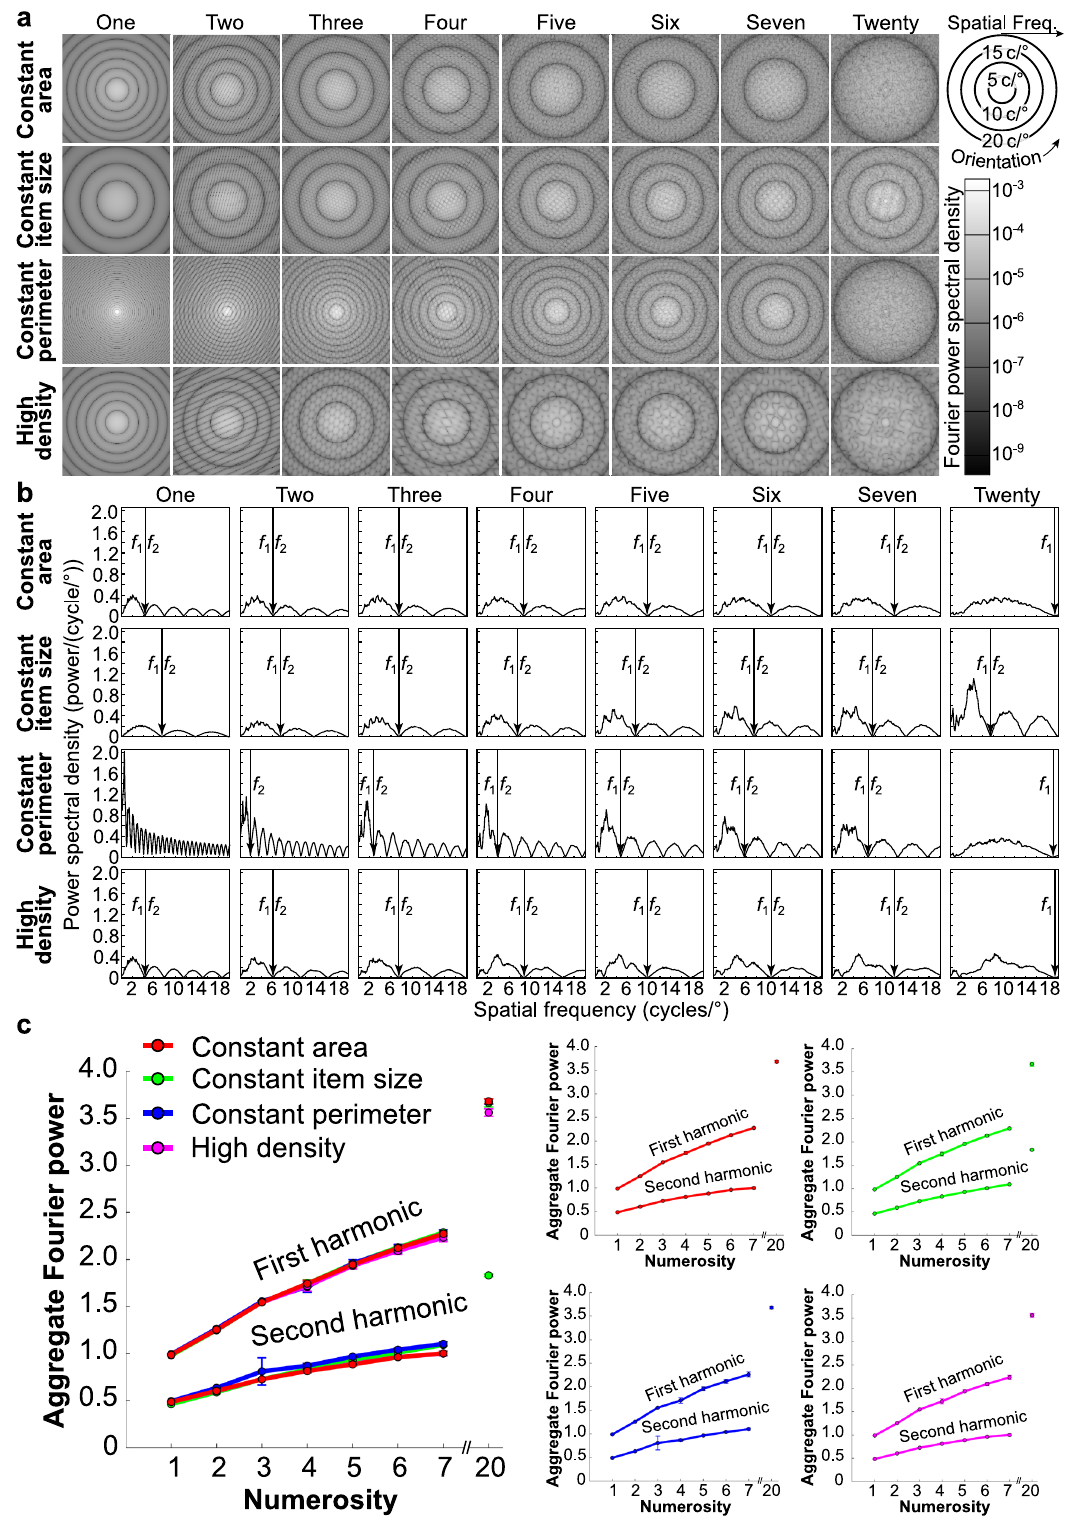
Fig. 3 Calculation of aggregate Fourier power for each stimulus con fi guration and its straightforward relationship to numerosity. a 2-dimensional Fourier transforms for each image in Fig. 1. b Fourier power spectral density at each spatial frequency, collapsed over orientation. The limit of the fi rst harmonic ( f 1 ) was used to determine the aggregate Fourier power of each image. c Aggregate Fourier power follows numerosity closely and similarly across stimulus con fi gurations. We divided aggregate Fourier power by the product of number display pixels and the square root of two here, making the power of one circle approximately one for any display resolution. Points show the mean power of all stimuli of the same numerosity in the same stimulus con fi guration, error bars show the standard deviation, n = 96 example stimulus images per numerosity. Left panel shows all con fi gurations overlaid; other panels show individual con fi gurations. Source data are provided as a Source Data fi